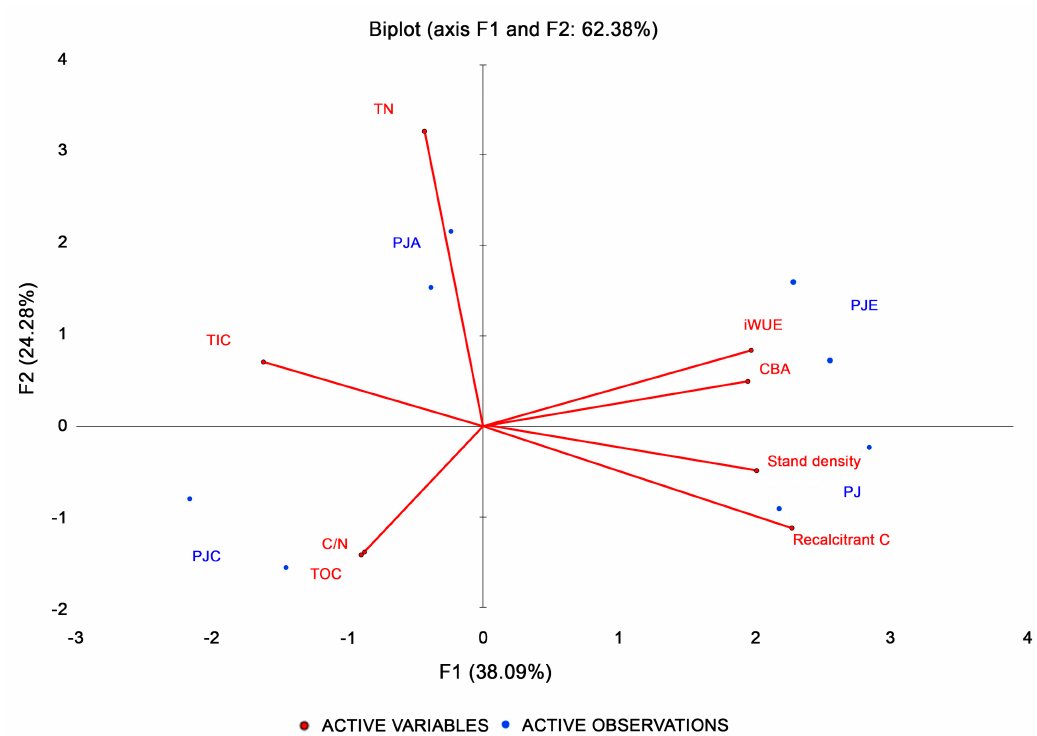
Figure 7. Biplot of the first two principal components, which accounted for the total variance of 38.1% and 22.3%, respectively. The length of the vectors (in red) indicates the strength of the correlations with respect to the active observations (intercropping systems, in blue). A strong positive correlation is indicated by vectors pointing in approximately the same direction as the active observations. Conversely, vectors pointing in opposite directions suggest a strong negative correlation.